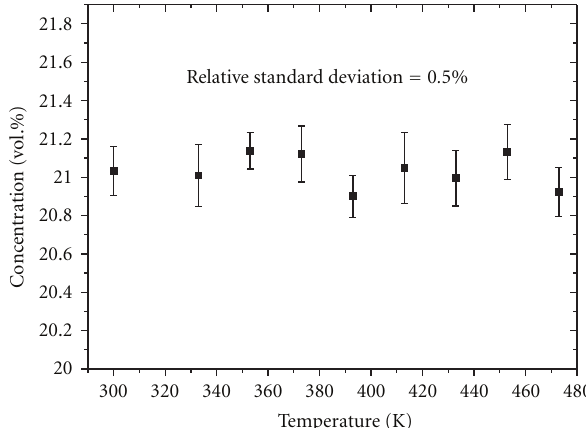
F 4: Concentration measurement evaluated by scheme A by usingatmosphericoxygenasasamplegasat9differenttemperatures between 300 and